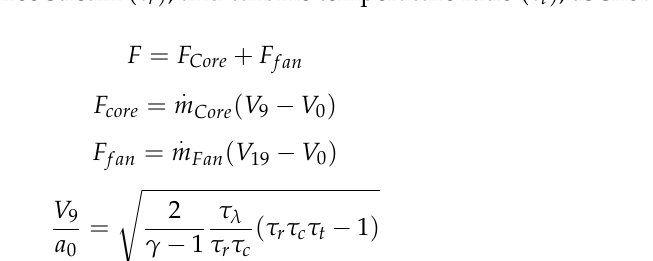
The turbine temperature ratio ( τ t ) in Equation (5) is obtained from the energy balance equation of the turbine work as shown in Equation